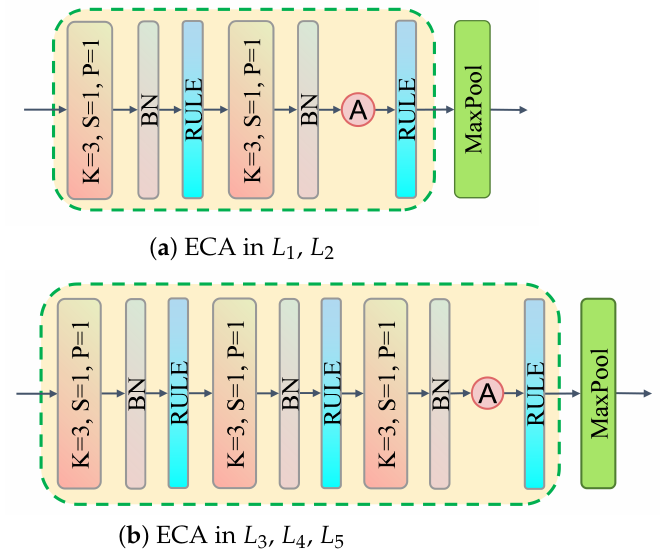
Figure 4. ECA module. ( a ) ECA module in L 1 and L 2 , ( b ) ECA module in L 3 , L 4 , and L 5 .